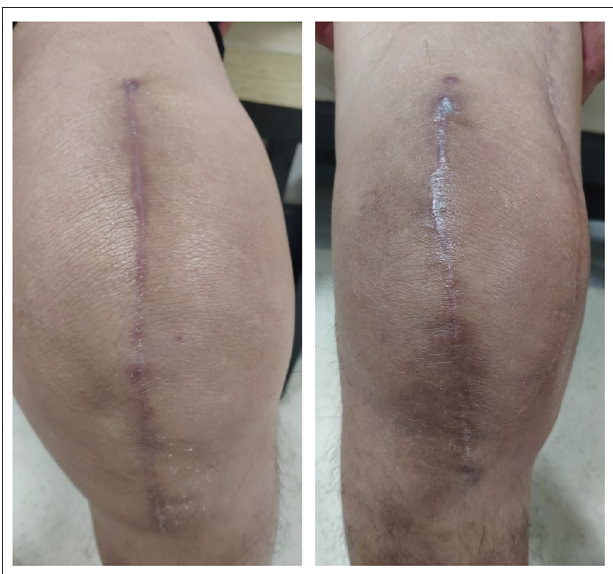
FIGURE 3 | The appearances of knee wound at post-operative one month (right: intervention group; left: control